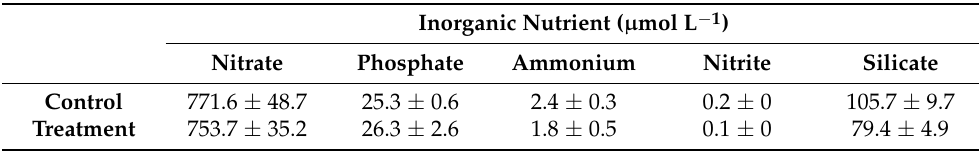
Table 1. Inorganic nutrient concentrations (mean ± S.D., n = 3) on day 10 of Experiment